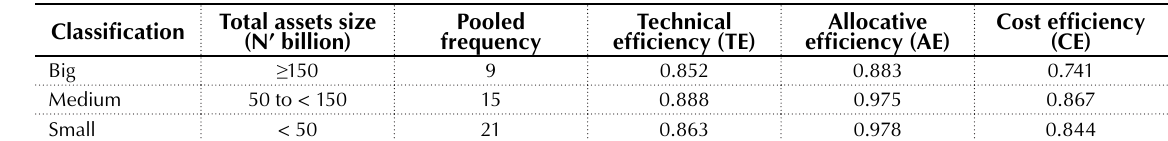
Table 4. A 3-year measured average efficiency of the deposit money banks in 2001‒2003 pre- consolidation period